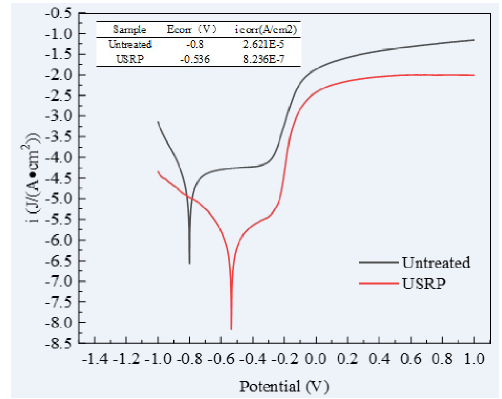
Figure 13. XRD spectra of GCr15 steel before and after USRP treatment.